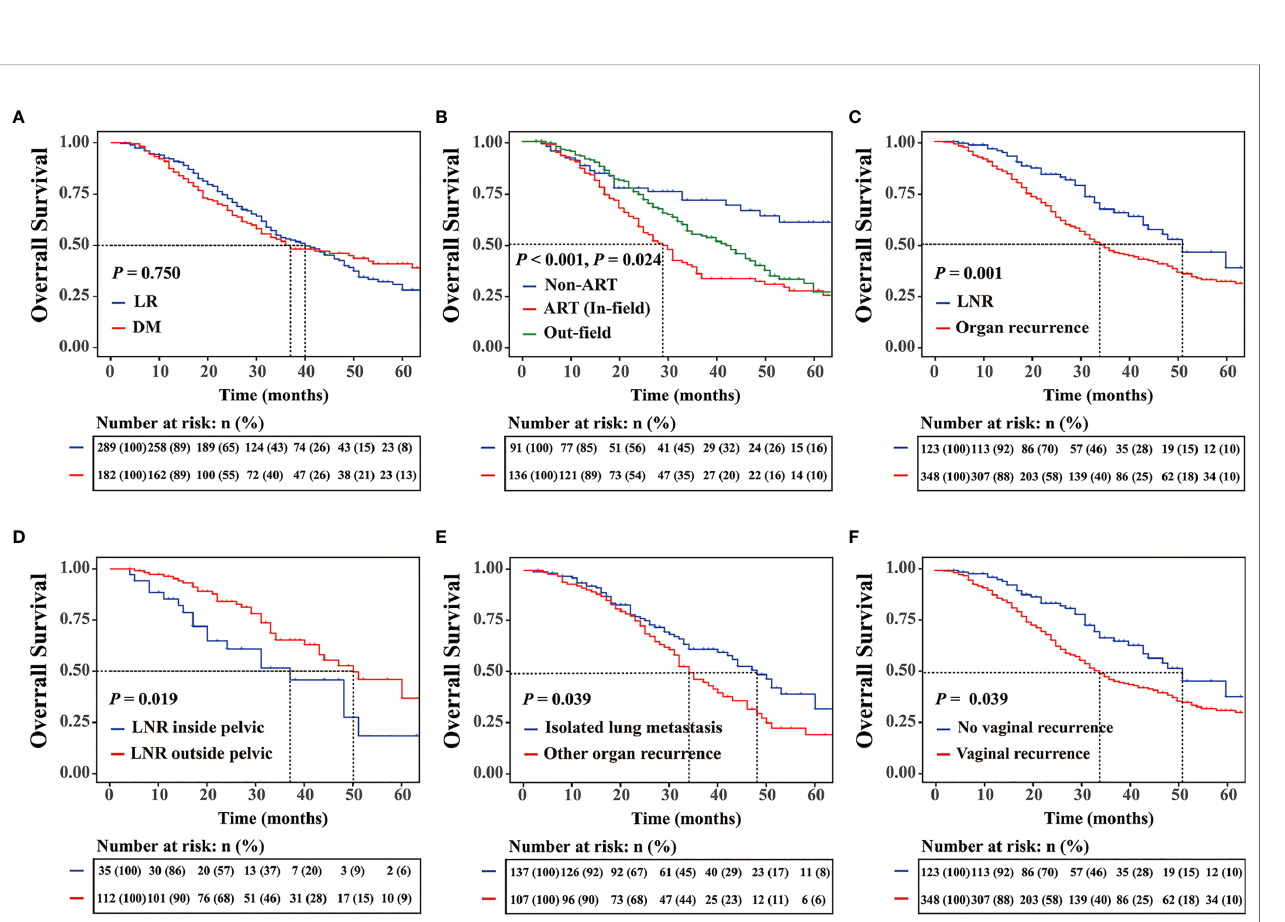
FIGURE 1 | (A) Five-year overall survival (OS) rates for different recurrence sites. (B) OS rates for patients with locoregional recurrence (LR) with or without adjuvant radiotherapy (ART) and the OS for patients with the out- fi eld recurrence. (C) Five-year OS rates for patients with different recurrence subtypes, (D) patients with lymph node recurrence, (E) patients with or without isolated lung metastasis, and (F) patients with or without vaginal stump.